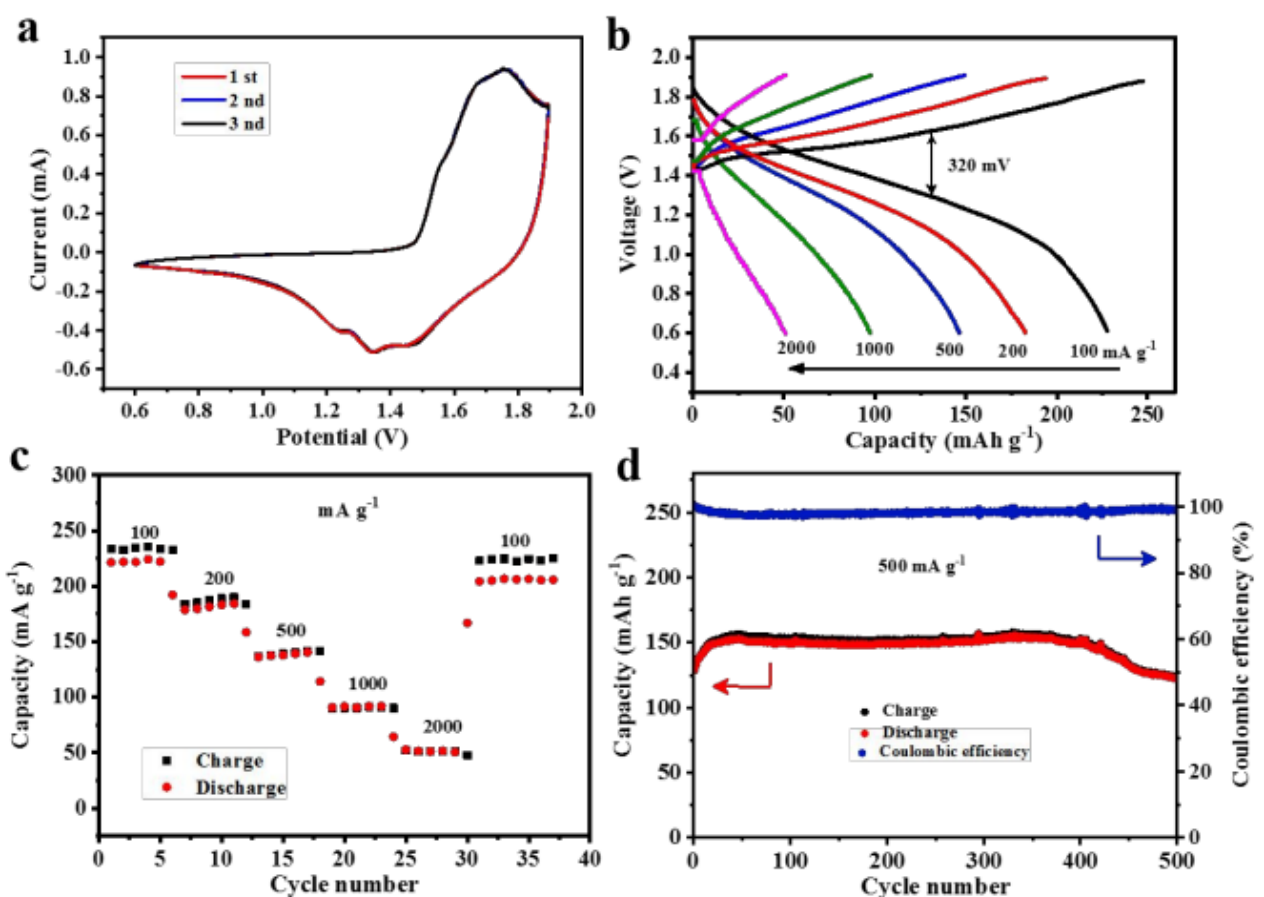
Figure 6. Electrochemical performance of the Zn/ ε -MnO 2 coin cells. ( a ) Cyclic voltametric (CV) curves of the Zn/ ε -MnO 2 cell at a scan rate of 0.1 mV s − 1 . ( b ) The discharge/charge voltage profiles at various current densities between 0.6 and 1.9 V. ( c ) Rate capability. ( d ) Long-term cyclic performance and the corresponding Coulombic efficiency at 500 mA g − 1 . Reprinted with permission from [35]. Copyright 2018 American Chemical Society .